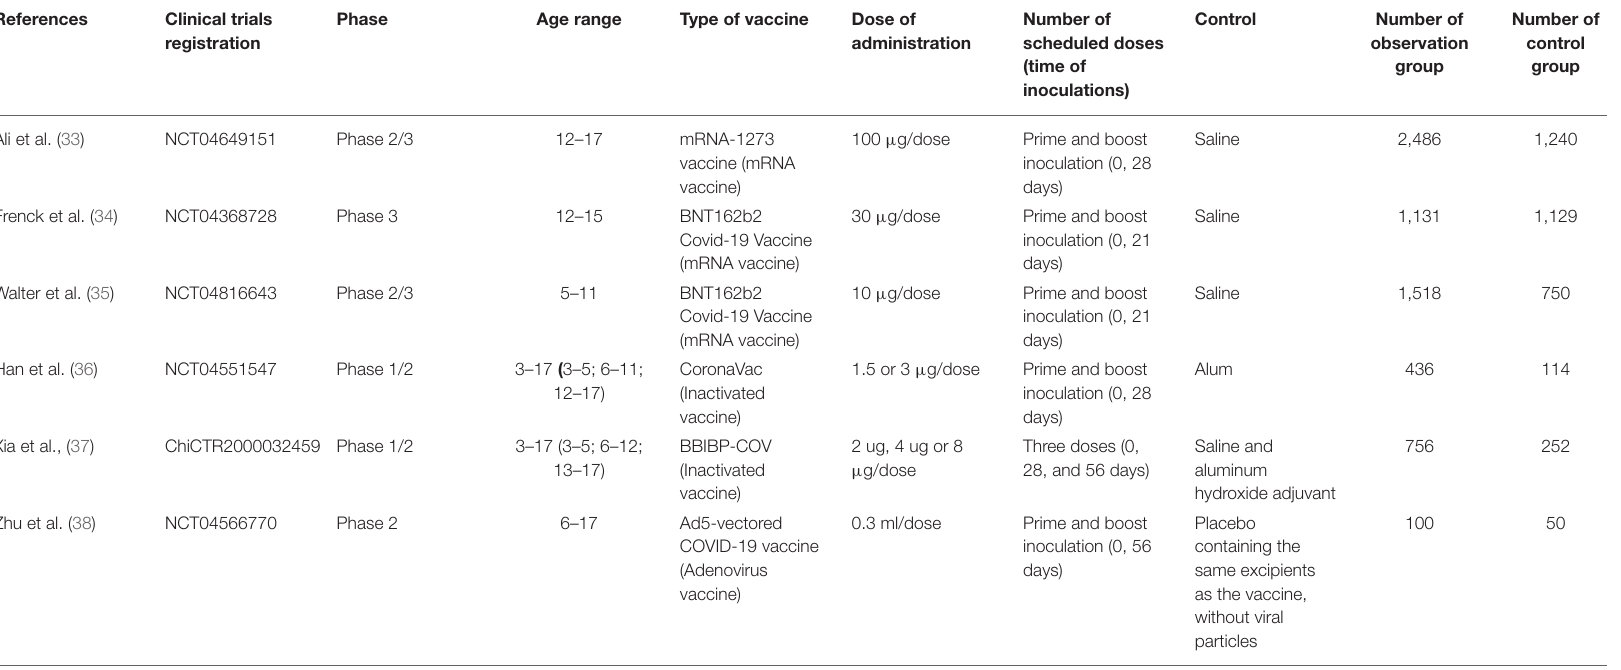
TABLE 1 | The characteristics of the included